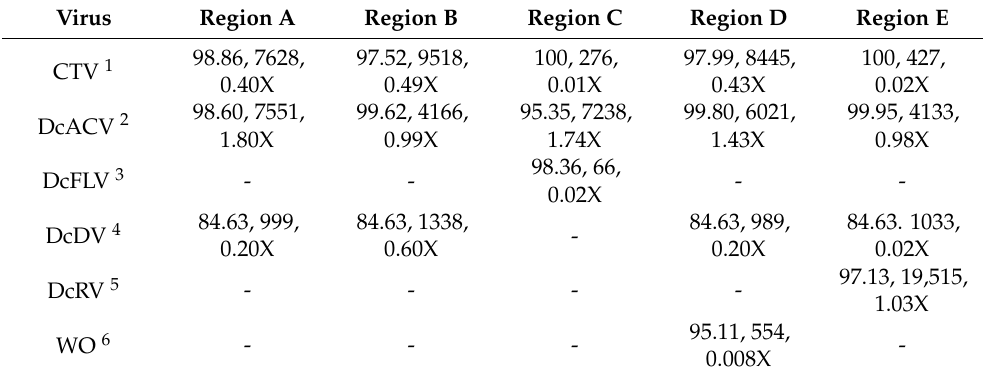
Table 5. Viral contigs annotated as known viruses of interest for 2020 Florida Regions A–E. Virus Region A Region B